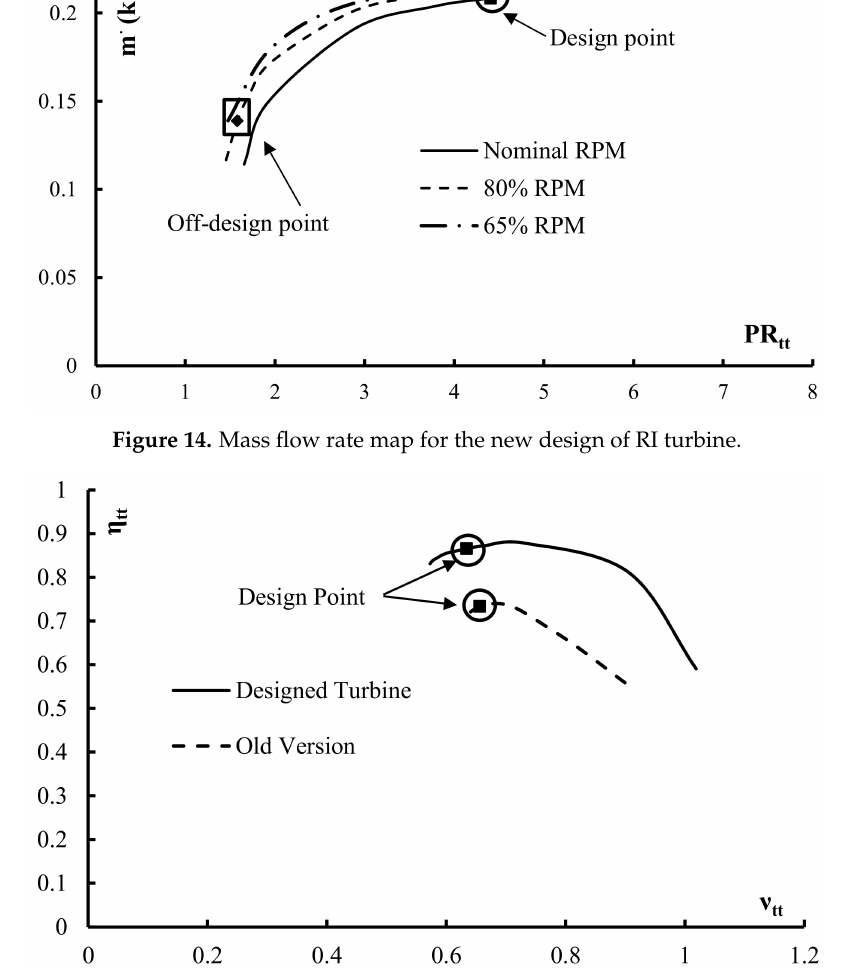
Figure 15. Comparison between the efficiency of the designed turbine and the current